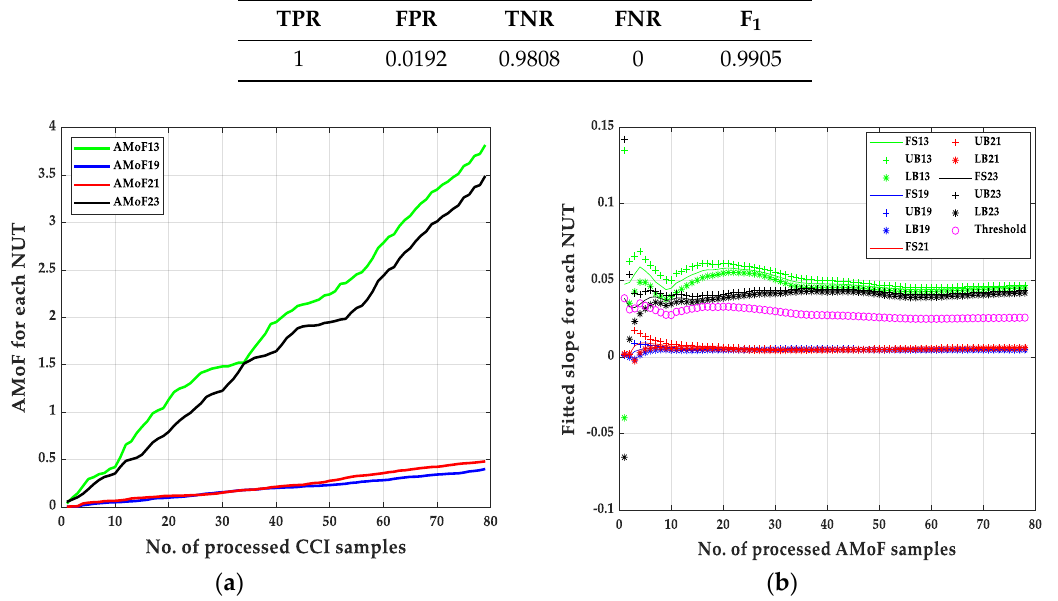
Figure 4. The AMoF and the fitted slope for different nodes for scenario NS15P7: ( a ) The AMoF for different NUT; ( b ) the fitted slope for NS15P7_BH_RWP 25/5. Table 4. Performance characterization for NS15P7_BH_RWP 25/5.